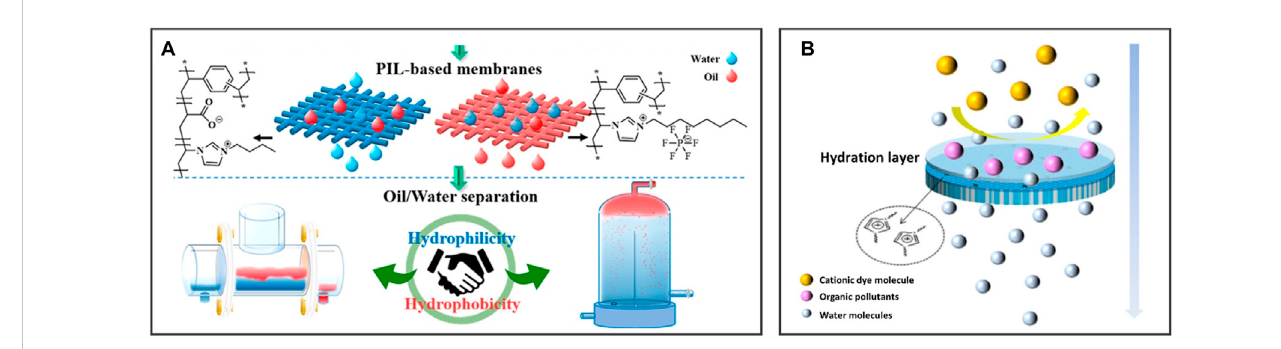
FIGURE 7 BILIMs for anti-liquid fouling. (A) Oil/water separation membrane with adjustable surface wettability realizes continuous oil/water separation without polluted by oil. Reproduced with permission (Deng et al., 2020). Copyright 2020, American Chemical Society. (B) ILs modi fi ed membrane can separate dyes and purify wastewater containing organic pollutant. Reproduced with permission (Liu et al., 2022). Copyright 2022, Springer Nature.